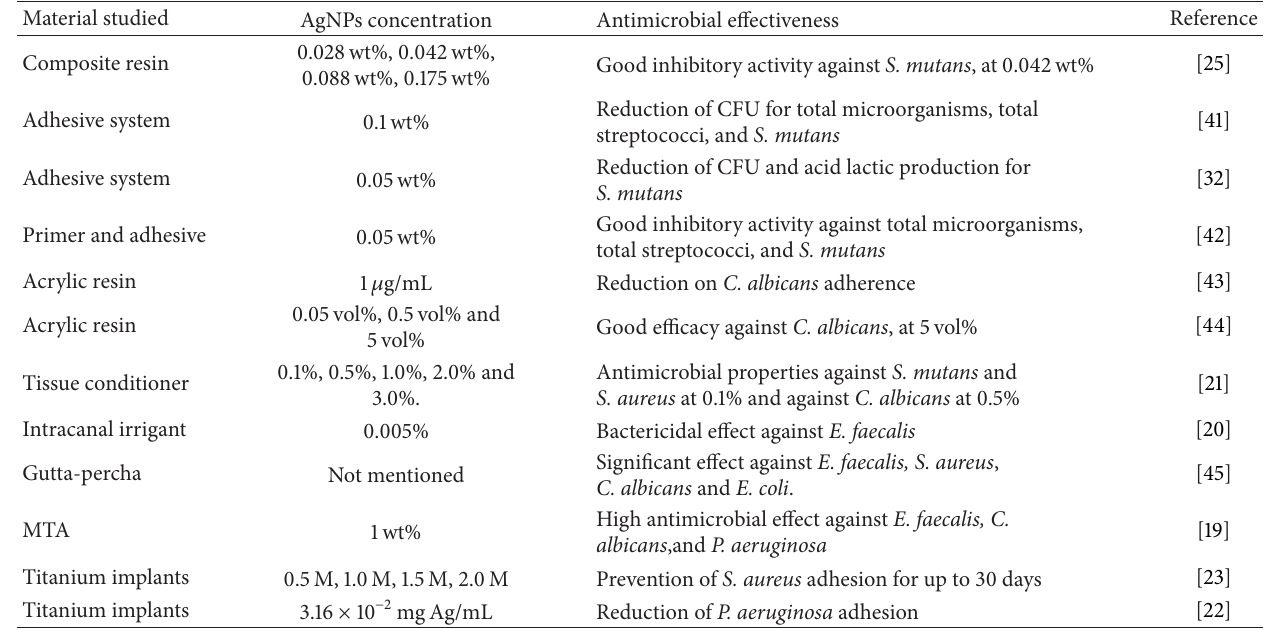
Table 1: Antimicrobial activity of AgNPs-containing dental